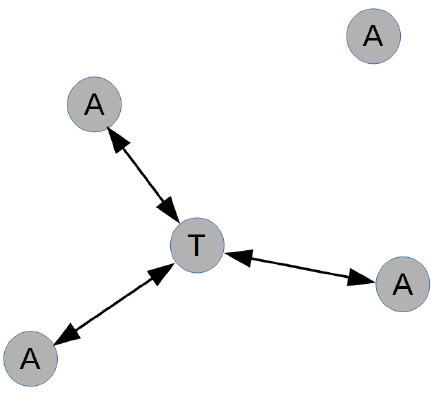
Figure 12. Localization of Tag.